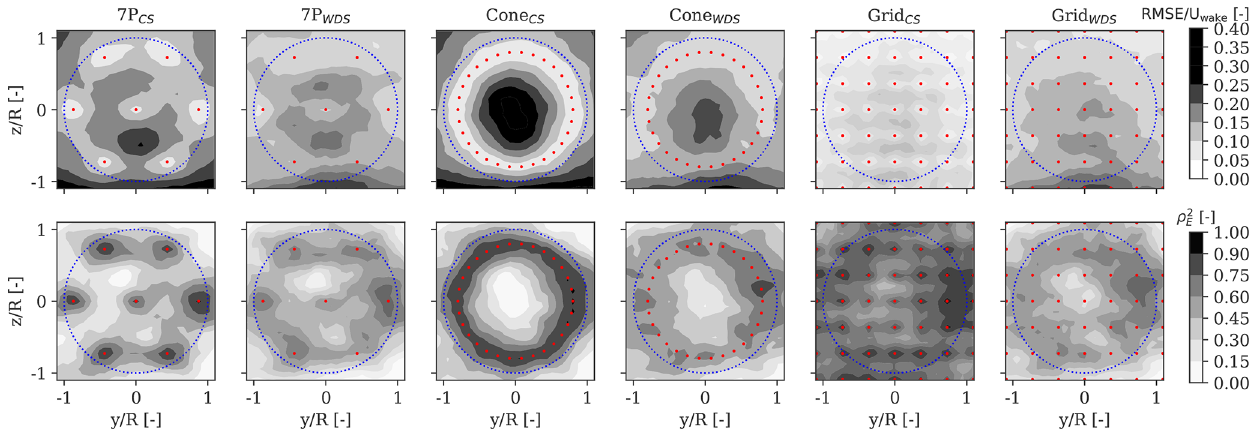
Figure 5. Spatial distribution of the error inherent to the CS- and WDS-reconstructed fields for selected scanning configurations. The top row refers to the RMSE normalized over the target velocity at each grid point ( U wake ). The bottom row refers to the explained variance ratio. The red markers identify the centers of the lidar beam sampling volumes. The wind turbine rotor is shown with dotted blue line.